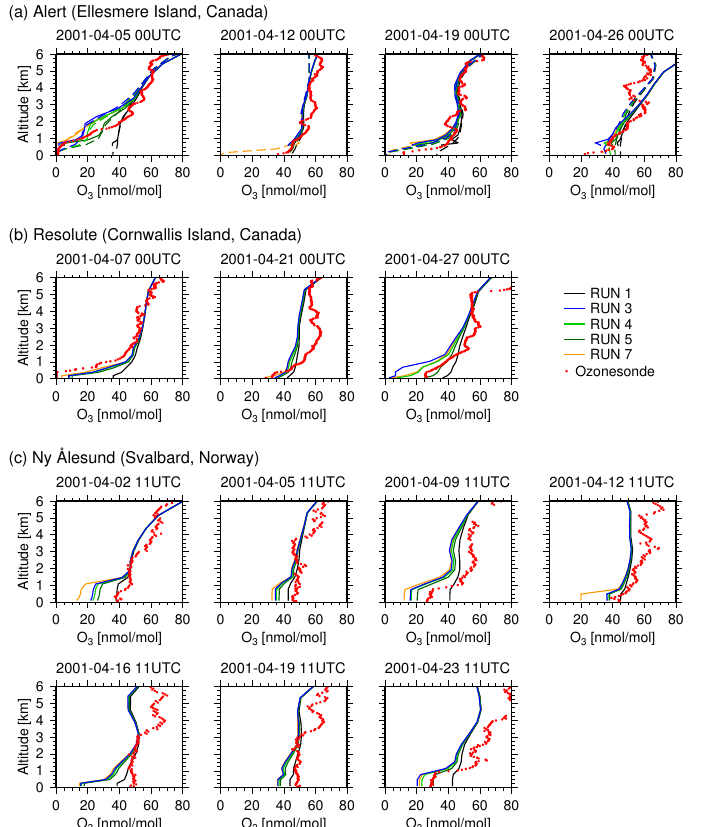
Fig. 4. (a) Comparison of simulated ozone profiles between 0–6kma.s.l. for Run 1 (black lines), Run 3 (blue lines), Run 4 (light green lines), Run 5 (dark green lines) and Run 7 (orange lines) with observed profiles by ozonesonde (red dots) at Alert CFS. Solid lines are the simulated ozone mixing ratios at the nearest grid cell (with a grid-mean terrain height of 565ma.s.l.) whereas dashed lines are those at one of the neighboring grid cells (location A 0 in Fig. 2b) with a grid-mean terrain height of 0ma.s.l.; (b) the same as (a) but at Resolute. Simulated profiles are shown for the nearest grid cell only (solid lines); and (c) the same as (b) but at Ny ˚Alesund.